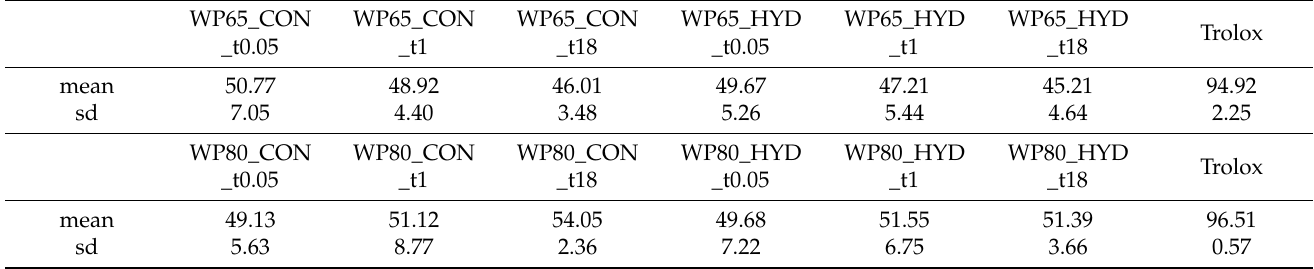
Table 6. % DPPH-RSA estimated as described in Section 2.2.3. Abbreviations explained in Table 1 and Section 2.2.3; s Means and standard deviations (sd) of three